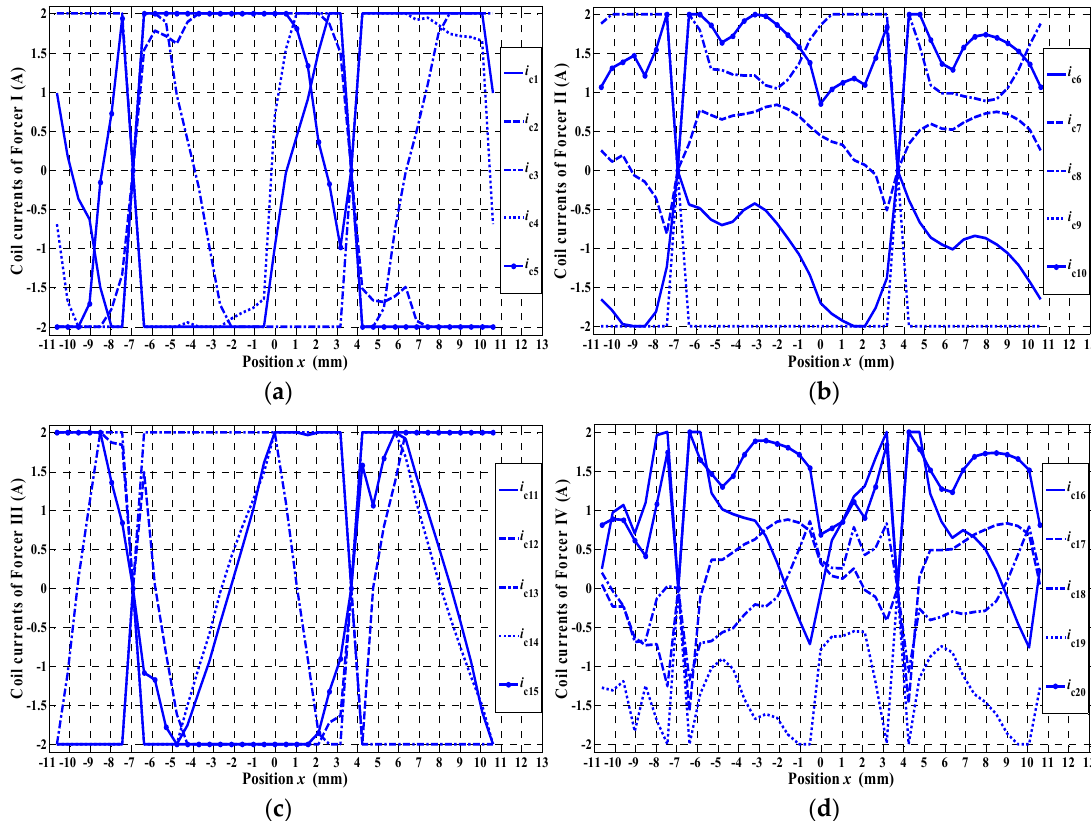
Figure 15 . Coil currents of ( a ) Forcer I, ( b ) Forcer II, ( c ) Forcer III, and ( d ) Forcer IV by optimization commutation with boundary constraint I m = 1.95 A.